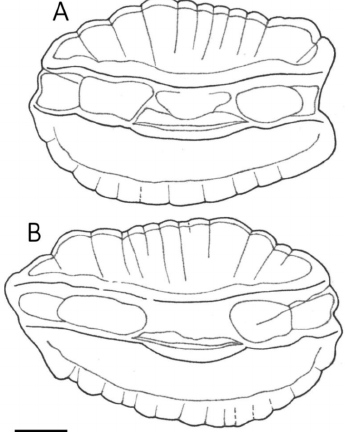
Figure 6. Otoliths of a single Gadiculus thori specimen (TL 143, SL 133) showing strong asymmetries between the right ( A ) and left ( B ) side otoliths (Kvinnheradfjord, Hardanger, Norway at approximately 170 m depth). Scale bar: 1 mm.